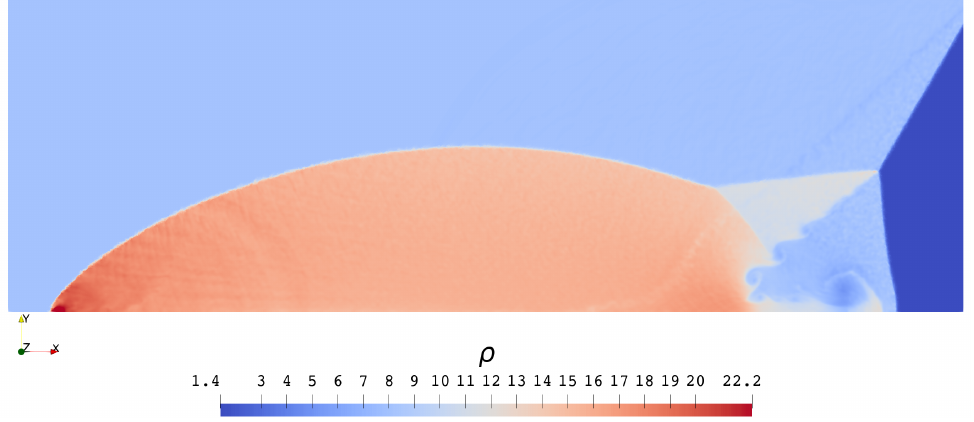
Figure 22. Third-order solution of ρ ( x , y , z = 0, t = 0.2 ) in Problem 6 ( h ≈ 1/200). Table 2. Performance of the same solver running on different number of